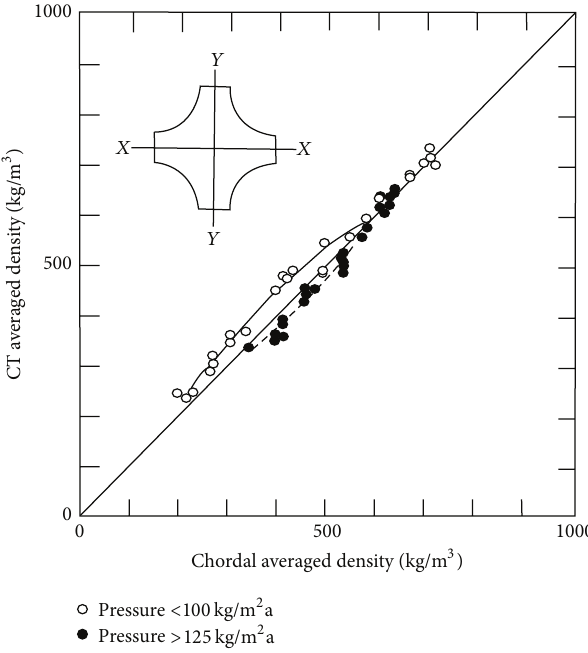
Figure 12: Relation Between Chordal and CT Averaged Densities (for S1).